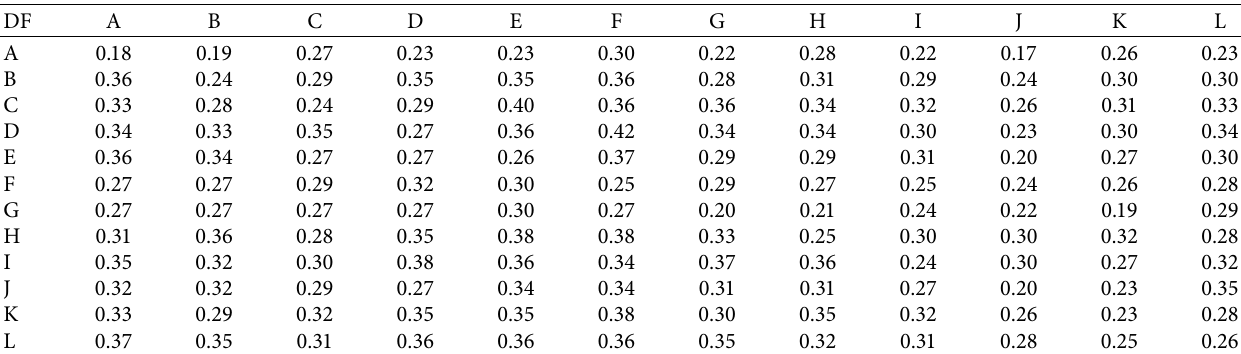
Table 9: The total defuzzy matrix.